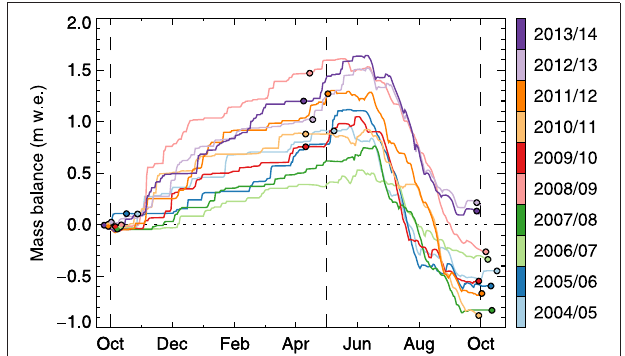
FIGURE 5 | Calculated daily evolution of glacier-wide mass balance for all years analyzed. Dots show the dates of measurements ( Table 1 ), and vertical stippled lines mark the summer and winter seasons according to the hydrologic year.